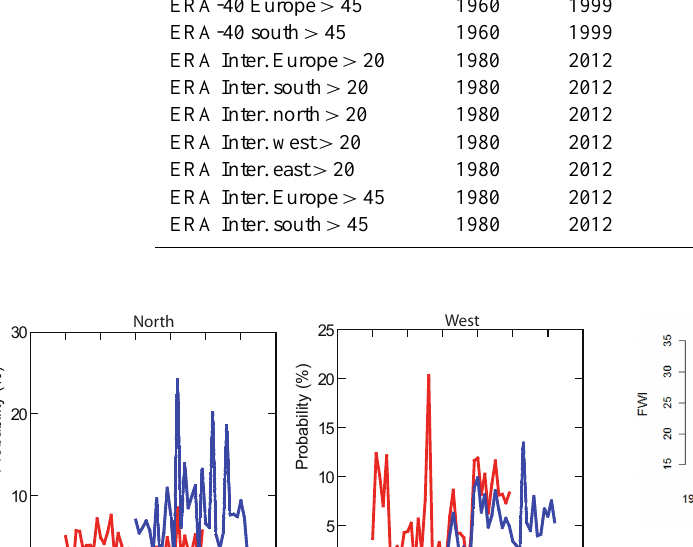
Figure 6. FWI time-series data based on ERA-40 and ERA Interim data for Greece. Vertical dotted lines correspond to forced break-